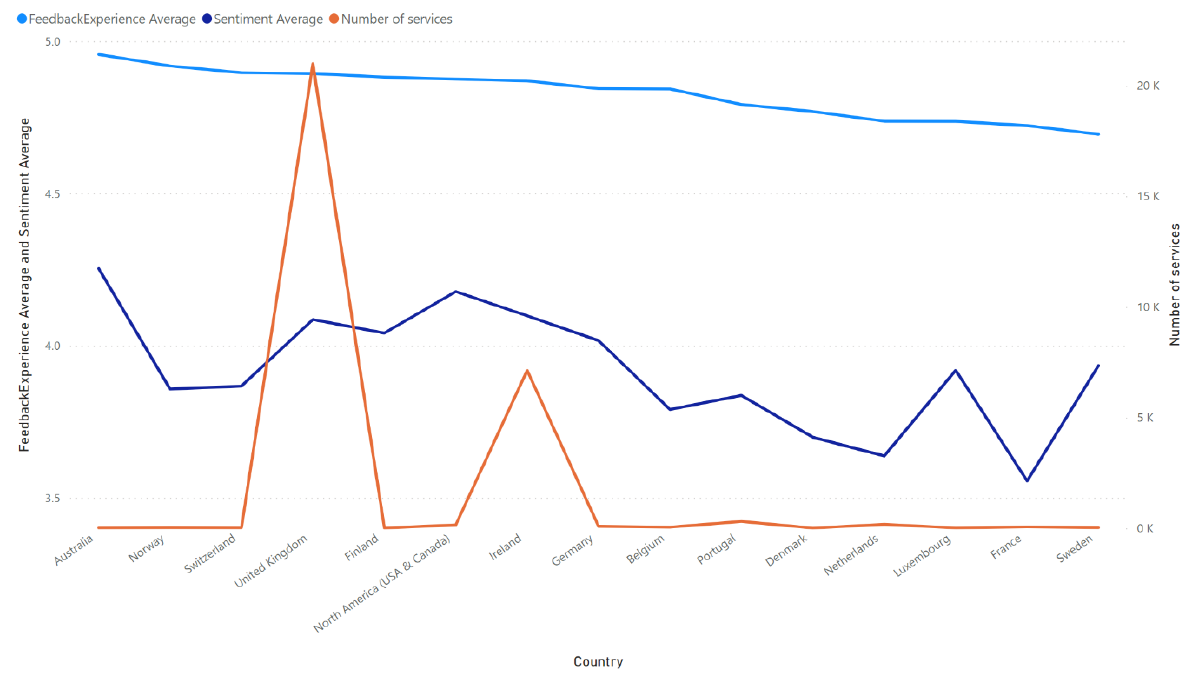
Figure 6. The sentiment expressed in reviews, experience feedback, and the number of services performed for countries that account for a number greater than or equal to 10 services.